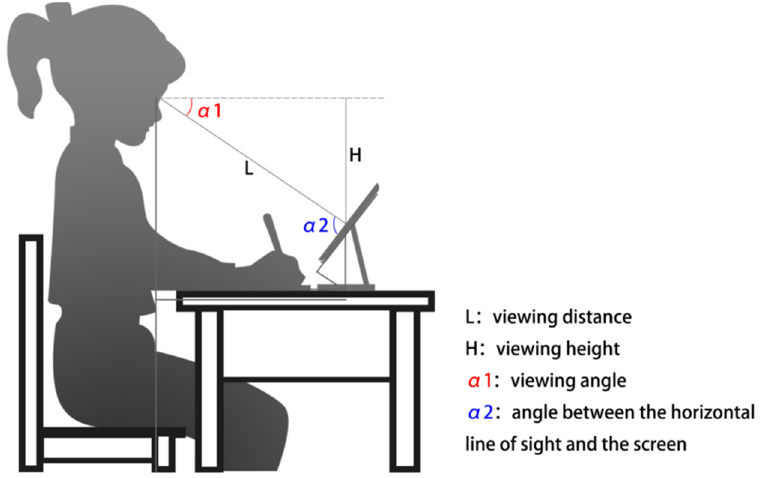
Figure 1. Independent variable measurement definition.